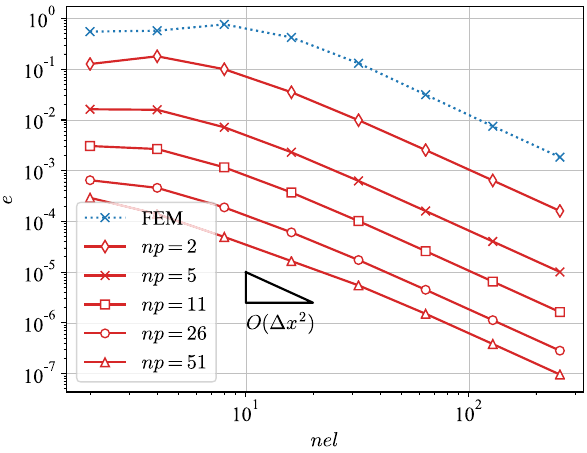
Fig. 10 Advection–diffusion–reaction with an exponential Source. Convergence of the error of P-DNS regarding the choice of np